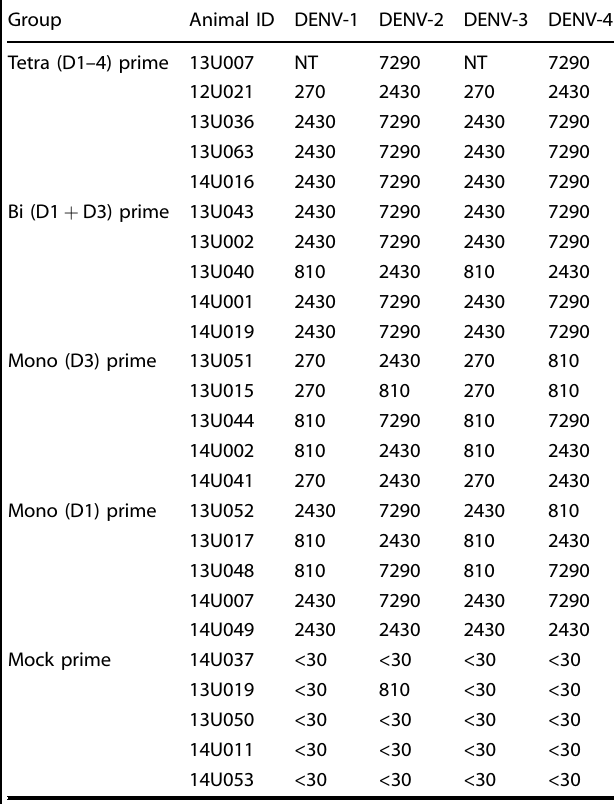
Table 2. Endpoint anti-DENV IgG titers from day 28 post-PIV vaccination.